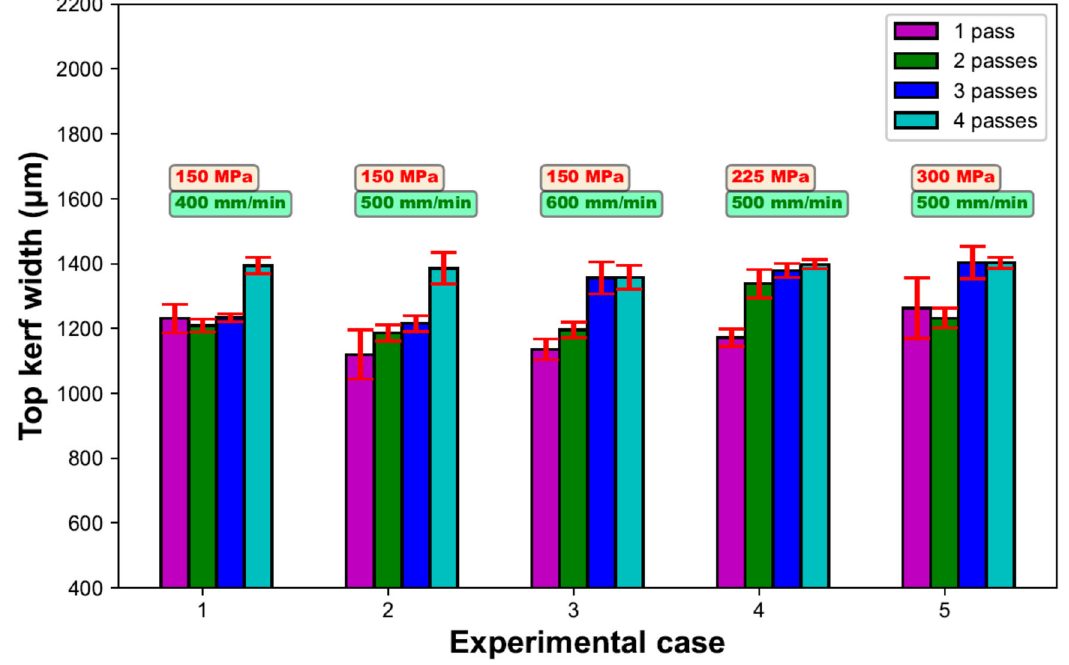
Figure 5. Variation of the top kerf width with an increasing number of passes and different process conditions.